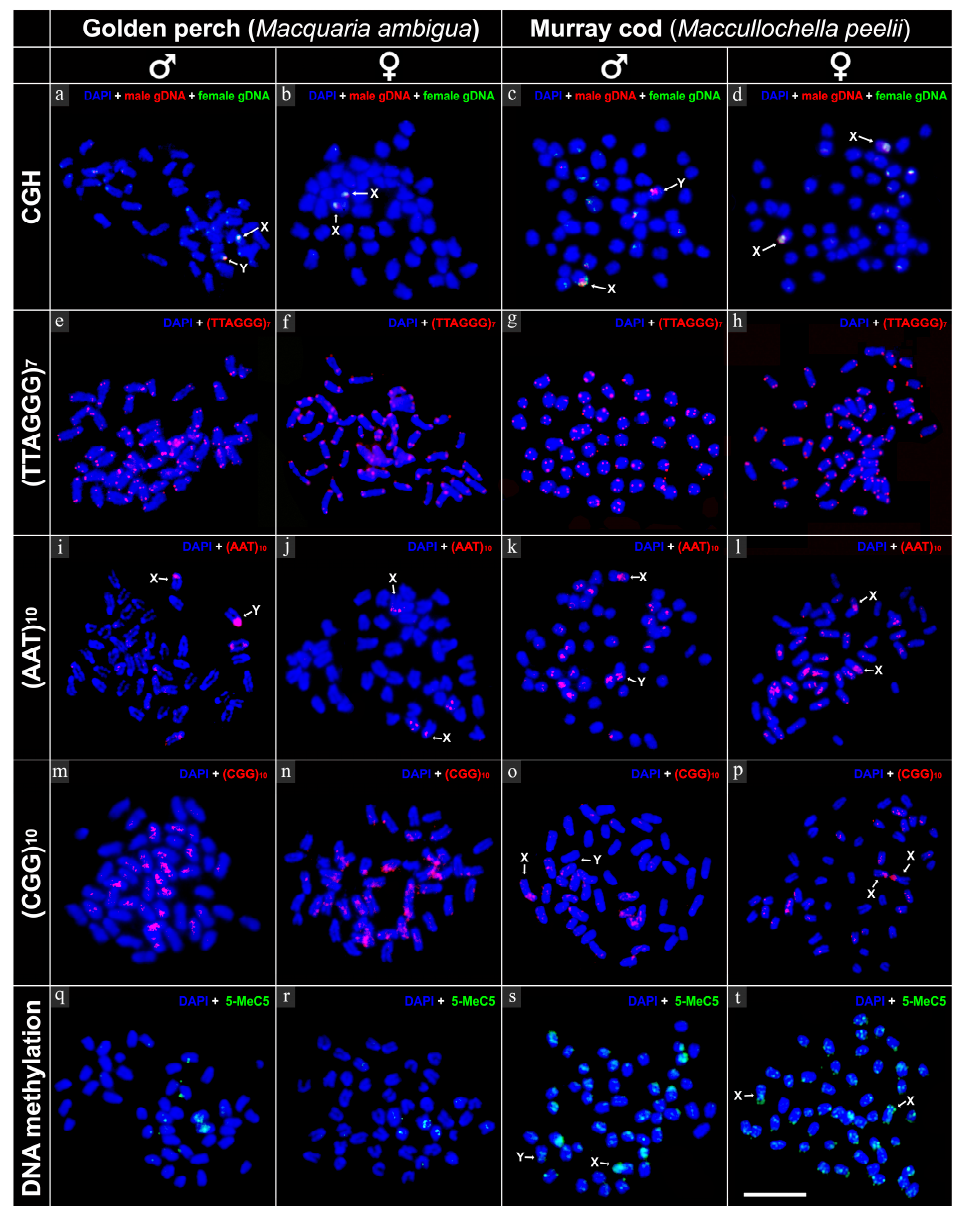
Figure 4. Fluorescence in situ hybridisation signals of genomic DNA (CGH, a – d ), telomeric probe ( e – h ), microsatellite motifs ( i – p ) and DNA methylation patterns in golden perch and Murray cod ( q – t ). CGH ( a – d ): hybridisation signals for fluorescently labelled genomic DNA of golden perch and Murray cod, showing hybridisation signals on X and Y sex chromosome; TTAGGG 7 ( e – h ): showing terminal hybridisation signals in all chromosomes; AAT 10 ( i – l ): hybridisation pattern of repetitive microsatellite motif (AAT) 10 , showing abundant accumulation on golden perch Y chromosome; CGG 10 ( m – p ): hybridisation signals from repetitive microsatellite motif (CGG) 10 , showing high accumulation on X chromosome of Murray cod compared with that of the Y chromosome. DNA methylation ( q – t ): immunofluorescent detection of DNA methylation, showing hypermethylated X chromosome in Murray cod compared with that of the Y chromosome. Scale bar represent 5 µm.